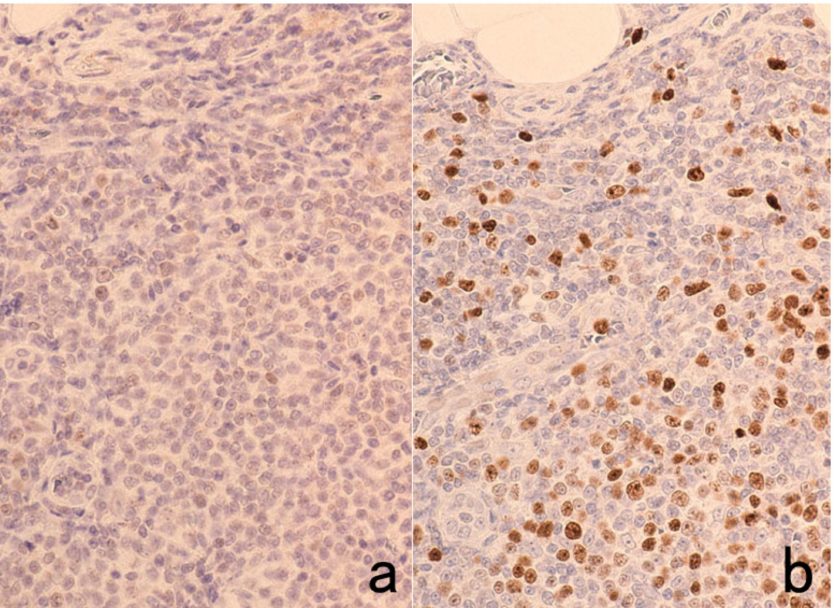
Figure 41. How to cool down after HIER. ( a ): Rapid cooling by soaking in tap water and ( b ): gradual cooling by leaving the slide container in the heating solution after it reaches room temperature. Ki-67 antigenicity in reactive lymphadenopathy becomes undetectable after rapid cooling. Sections after gradual cooling reveal distinct nuclear labeling.